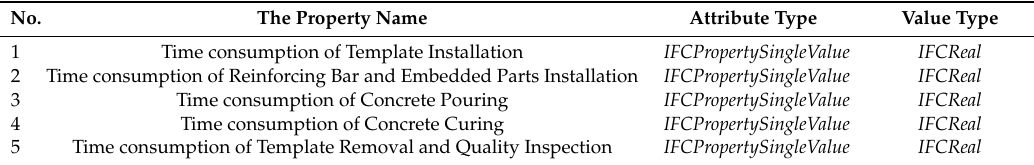
Table 5. The definition of the time–cost properties in each production